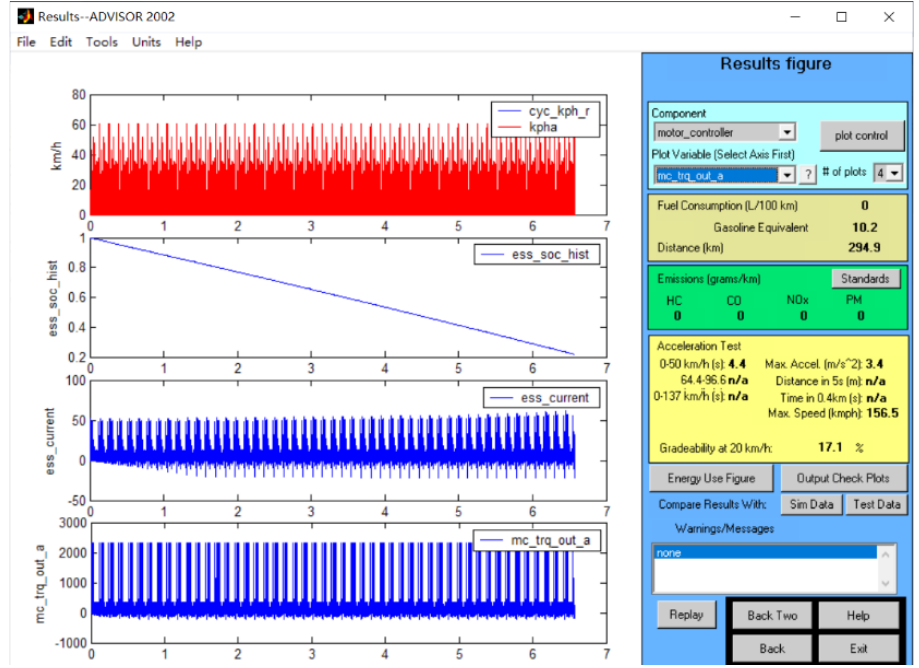
Figure 12. Simulation results of experiment 4.